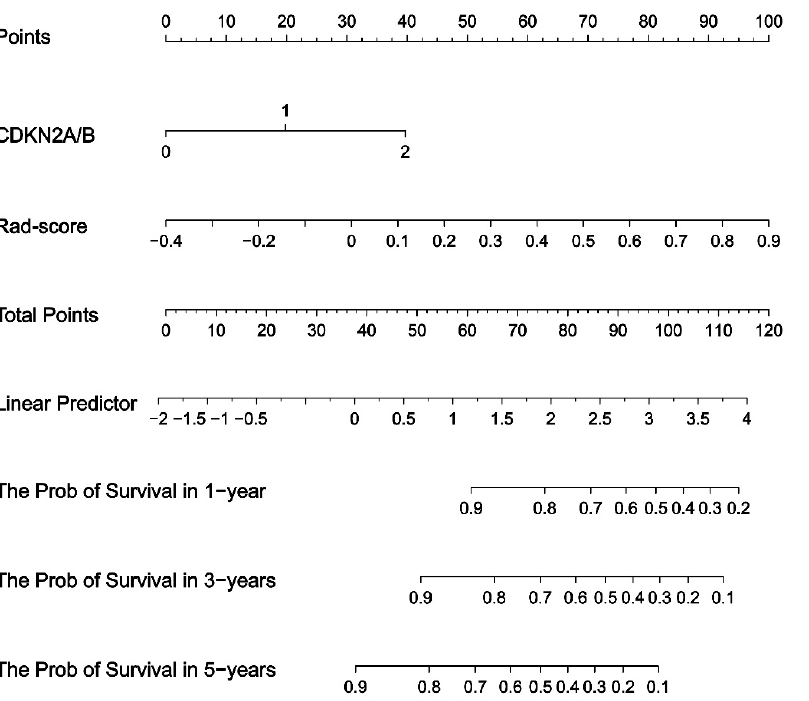
Figure 4. Calibration curves for the prediction model of CDKN2A/B homozygous deletions. ( A ) Training set and ( B ) Validation set.